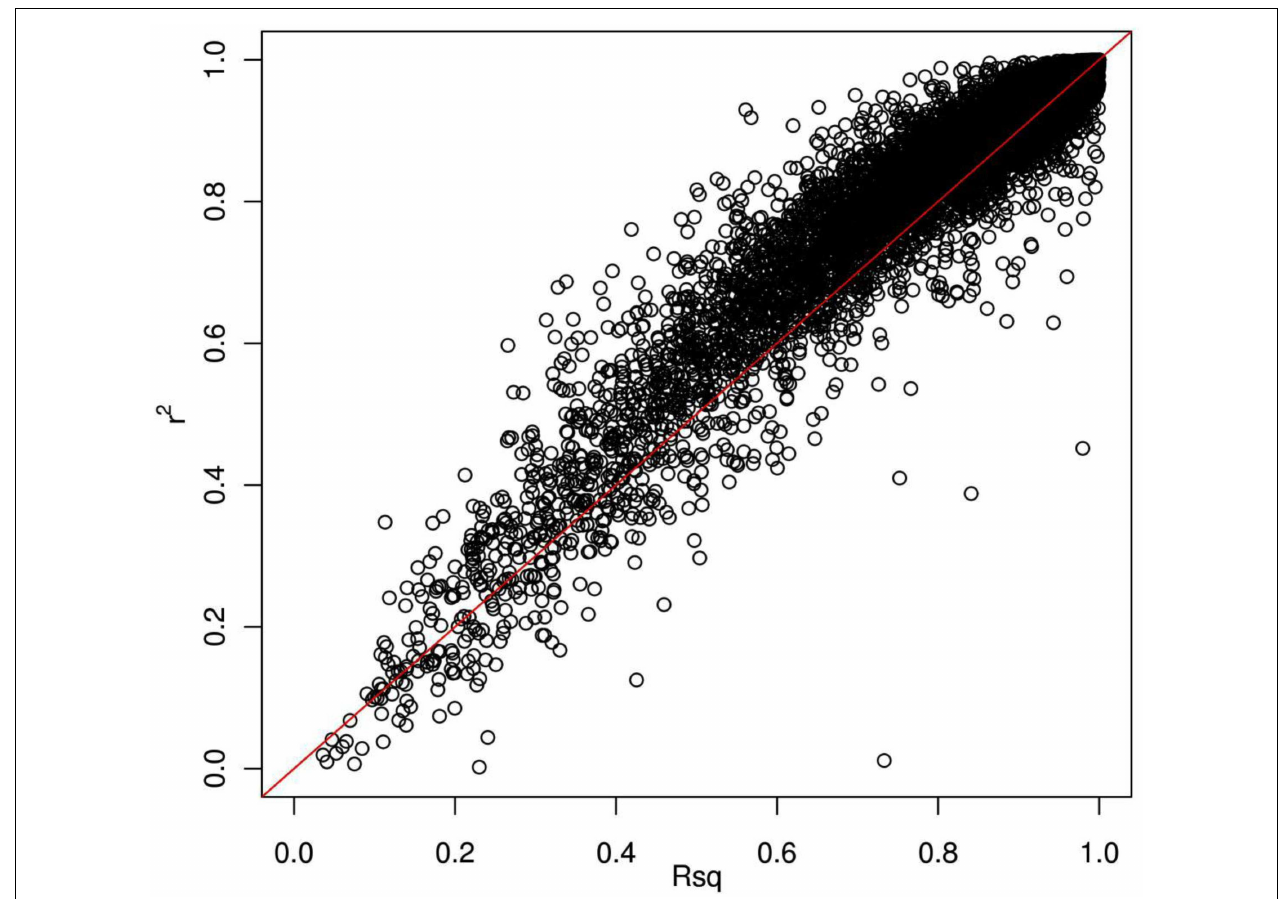
FIGUREA2 | Pairwise plot of the dosage r 2 by the MACH Rsq for chromosome 9. Diagonal line (red) is a perfect match between the MACH Rsq and the dosage r 2 . Further off the diagonal line means poorer